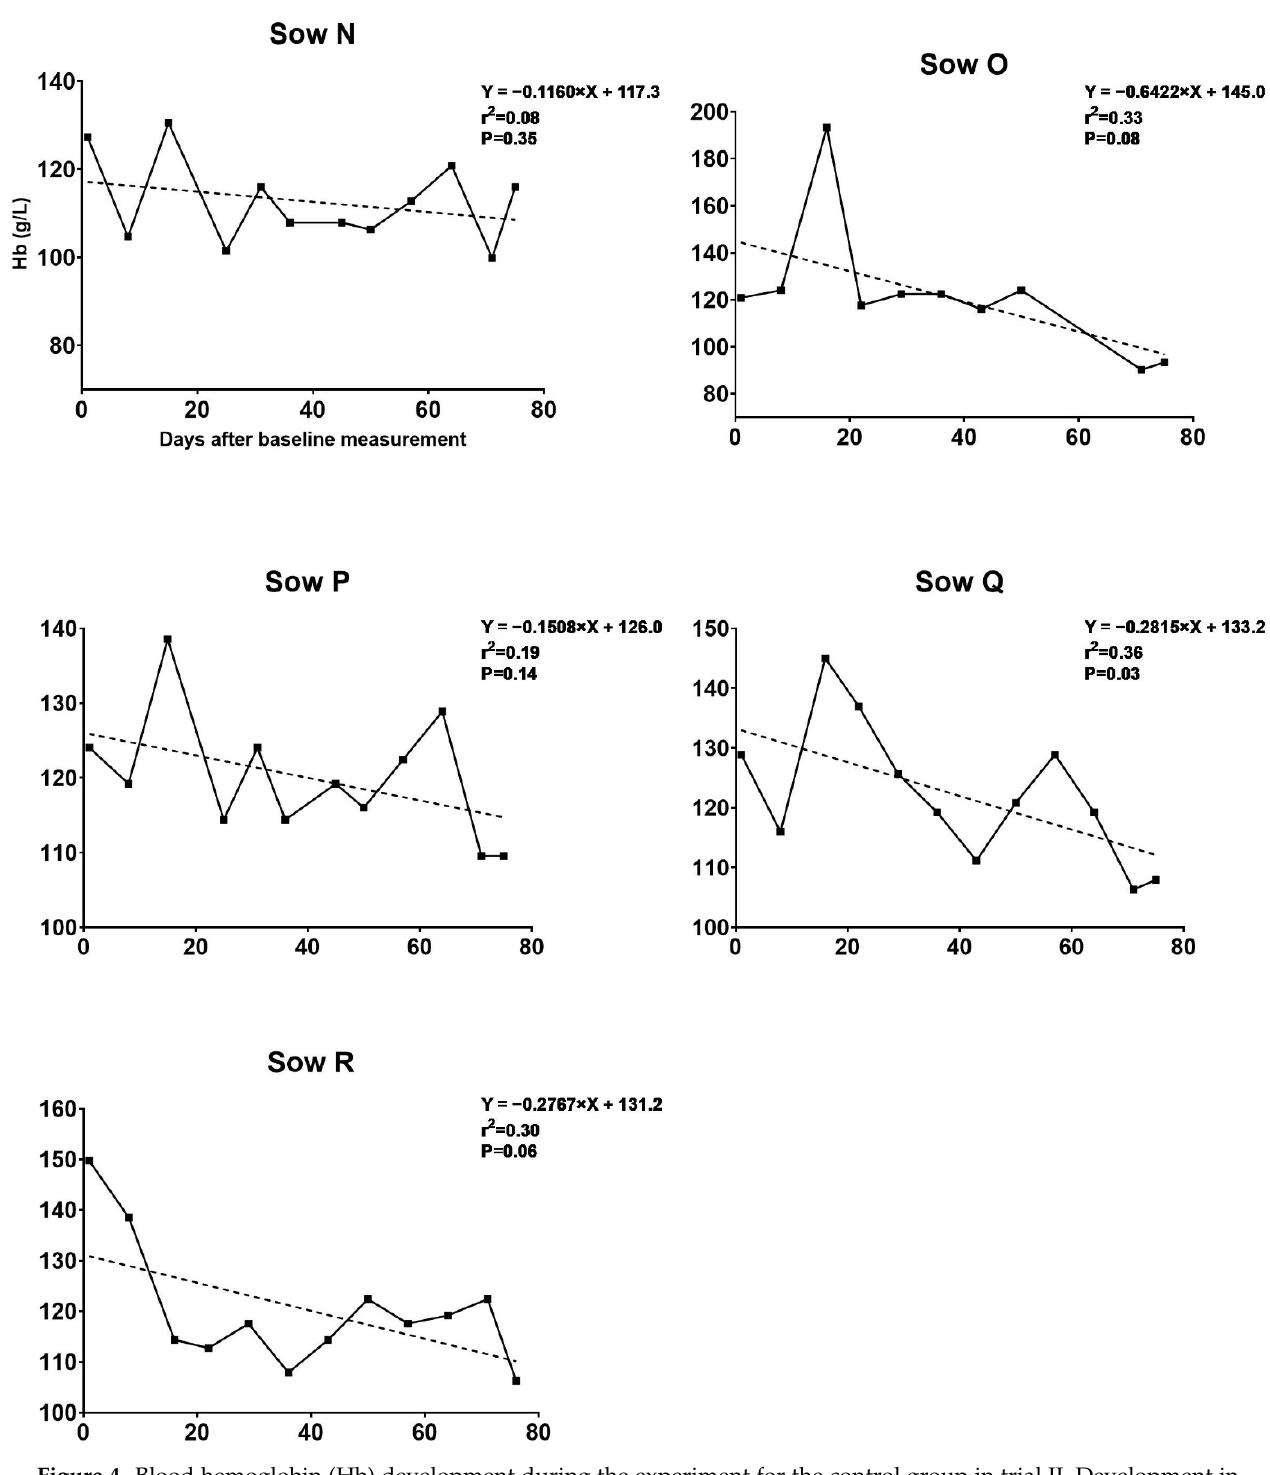
Figure 4. Blood hemoglobin (Hb) development during the experiment for the control group in trial II. Development in blood Hb levels during gestation in control sows fed a gestation diet with an iron supplement. The Hb levels of five sows were monitored from gestation day 42–44 until farrowing. The regression lines indicate slight decreases in Hb levels as gestation progressed. With the exception of Sow Q, we found relatively uniform progressions in Hb levels, with slopes of lines not significantly different from zero.